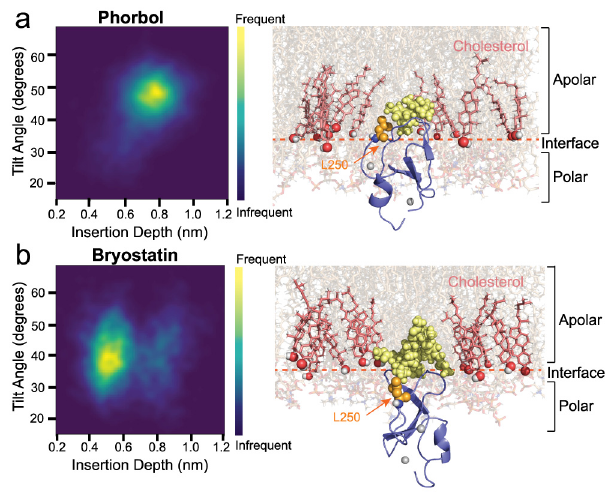
Figure 4. Topology of δ C1b-ligand complexes. Topology of δ C1b bound to ( a ) phorbol and ( b ) bryo- statin. Each heatmap is an average for all five simulations for each complex over a total 2.5 µ s simulation time. Areas of greater intensity represent topologies more frequently found in each simulation. Structural snapshots show the positioning of the L250 residue (orange spheres) relative to the cholesterol hydroxyl (shown as red spheres). The polar:apolar interface is indicated by the dashed red line and is positioned at the average position of the glycerol backbone of phospholipids.